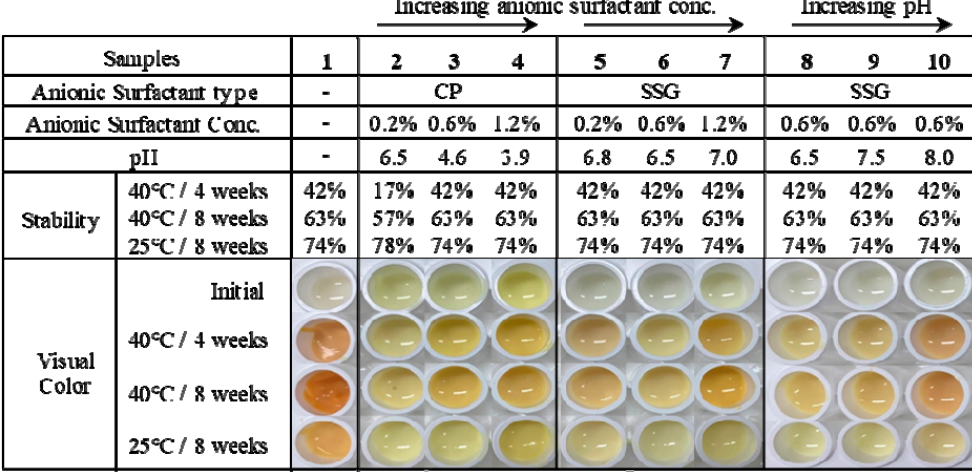
Figure 2. pH values, thermal stabilities, and visual color changes of nanostructured lipid carriers (NLC-ROLs) at different temperatures and durations. Table 3. Mean sizes, PDI values, and zeta potentials of nanostructured lipid carriers (NLC)-ROLs containing an anionic surfactant.